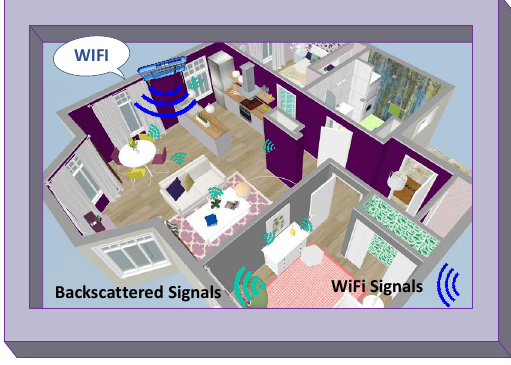
Figure 41. The concept of a smart home using